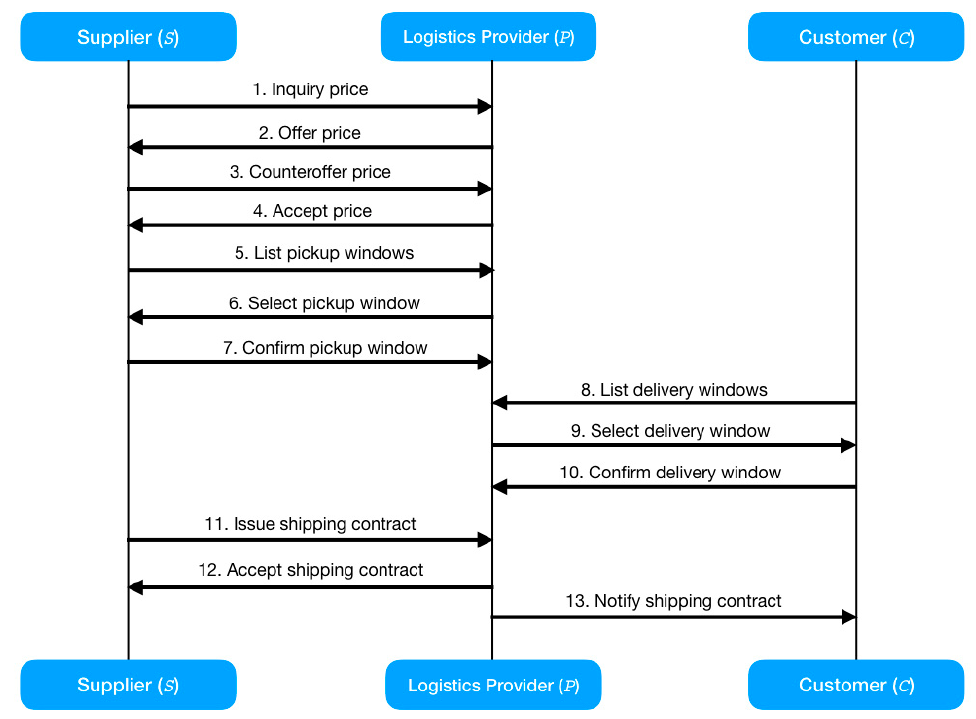
Figure 6. Shipment pricing and scheduling in TransICE.